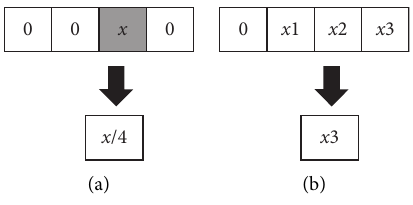
Figure 6: Two typical cases of